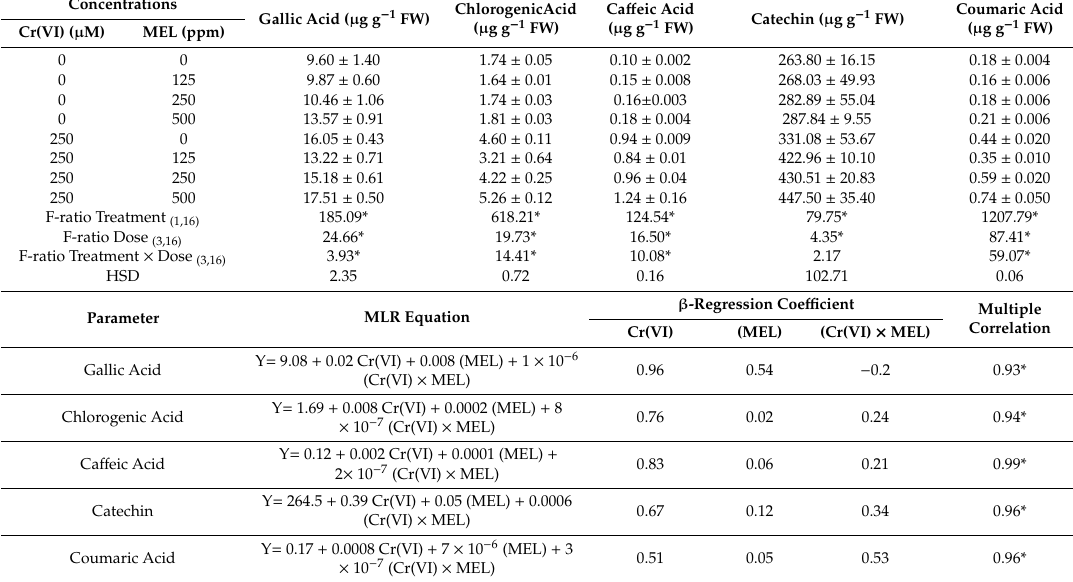
Table 7. E ff ect of Cr(VI), di ff erent concentrations of methanol extract of Rhododendron arboreum leaves (MEL), and their combinations on polyphenol contents in 7-day-old Vigna radiata seedlings. The values are the means of three replicates ± S.D. (standard deviation). Tukeys test performed and significance checked at * p ≤ 0.05. The F ratio is the term in which ANOVA is represented; Cr(VI) = Dose, MEL treatments = Treatment and combination of Cr(VI) and MEL = Dose × treatment.